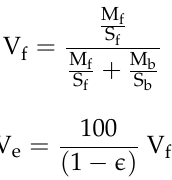
Table 3. Compositional and effective volume calculation.